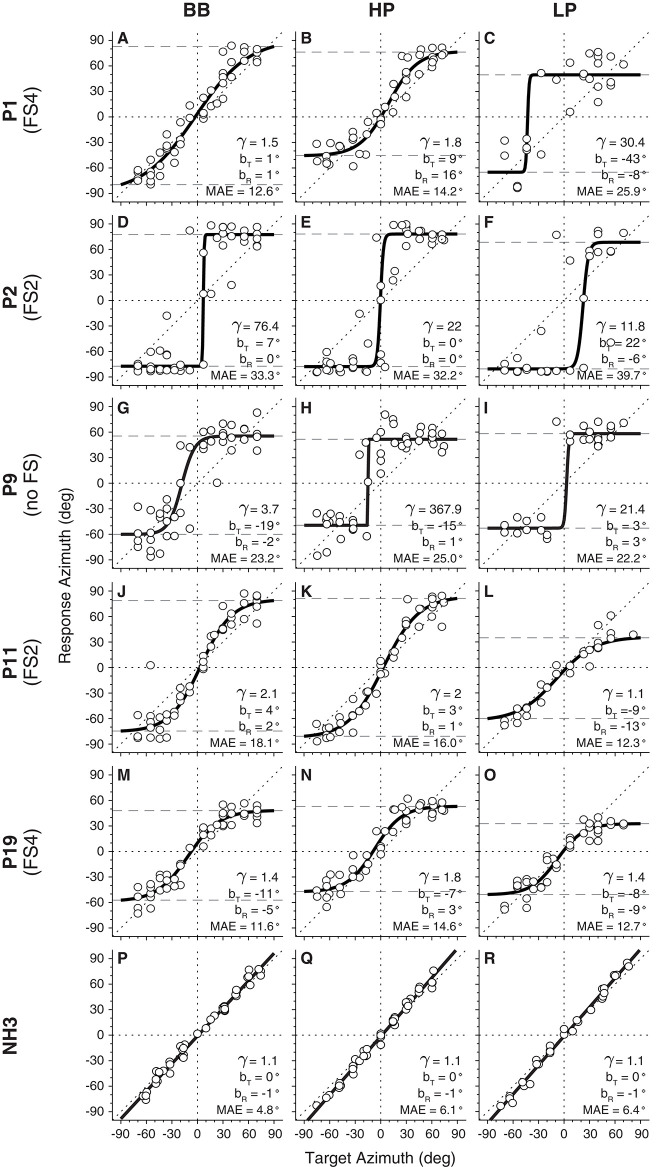
Target–response relationship of horizontal sound localization for broadband (BB), high-pass (HP), and low-pass (LP) stimuli. Five examples of BICI listeners (A–O) are presented, illustrating the overall performance of the group. A normal-hearing (NH) control listener (P–R) is shown as reference.